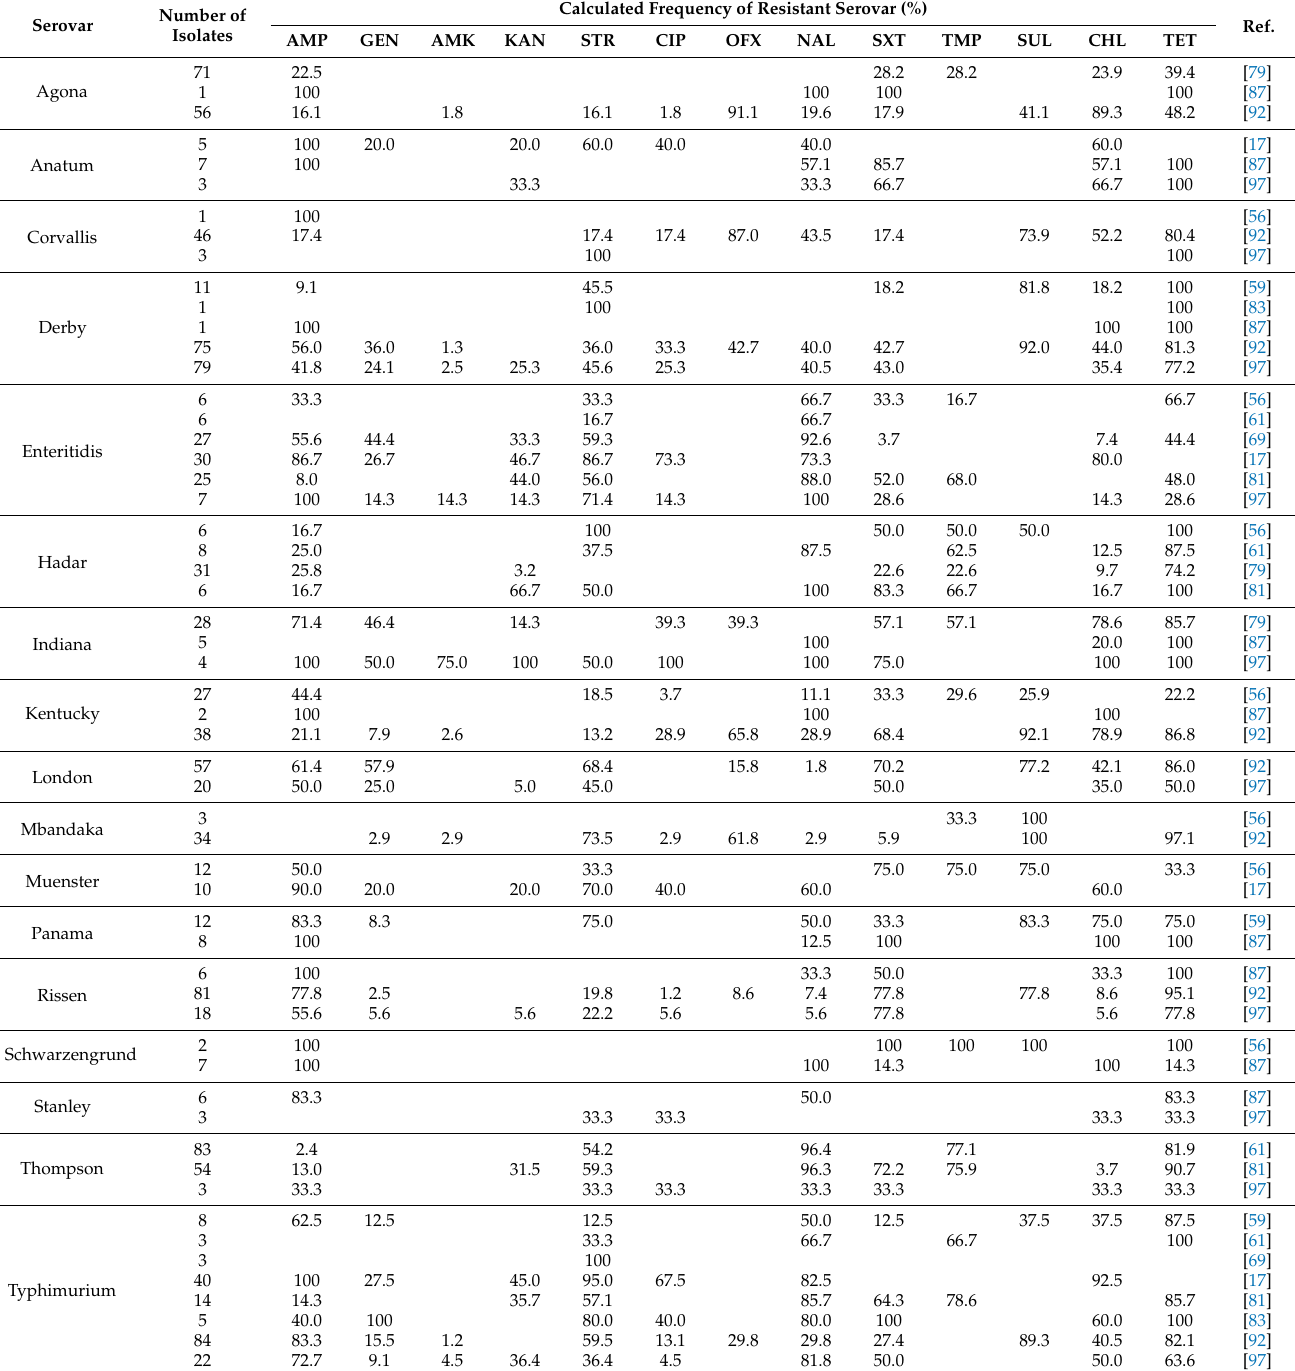
Table 4. Frequency of Salmonella isolates resistant to antimicrobials as determined by disc